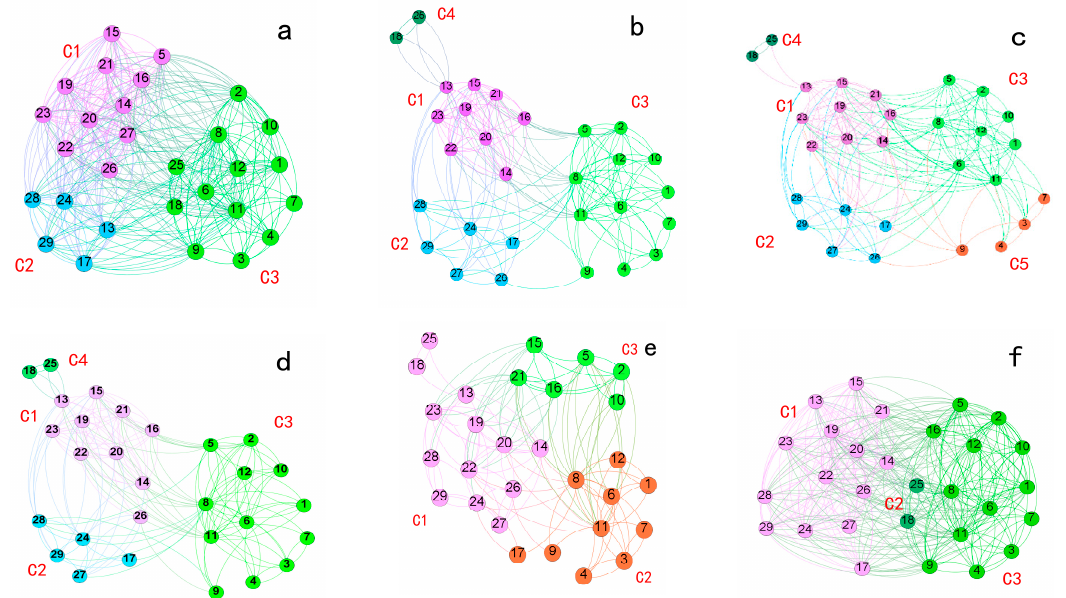
Figure 13. Topology views with the multi-force directed layout method: ( a ) layer1, ( b ) layer2, ( c ) layer3, ( d ) the overlap layer of layer1 and layer2, ( e ) the overlap layer of layer1, layer2, and layer3, and ( f ) the aggregation layer.